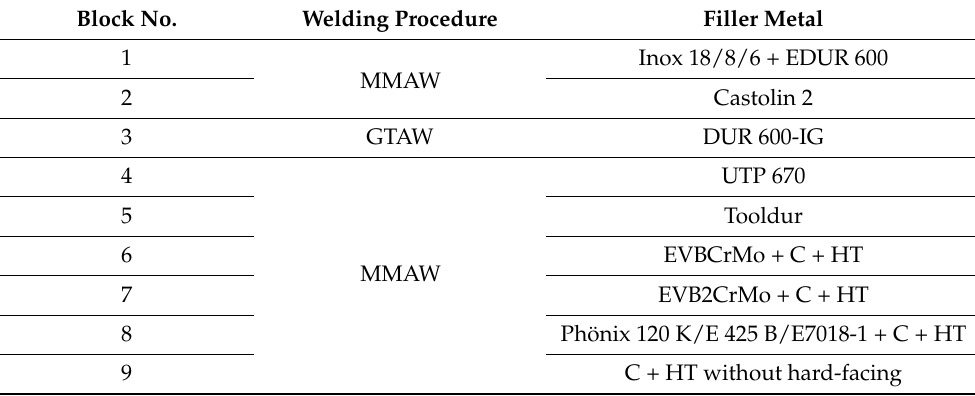
Table 6. Experimental blocks notation and hard-facing procedure. Block